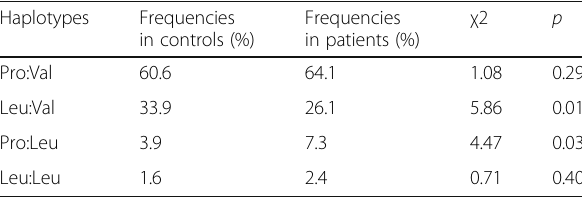
Table 4 Haplotype frequency distribution among patients and controls Haplotypes